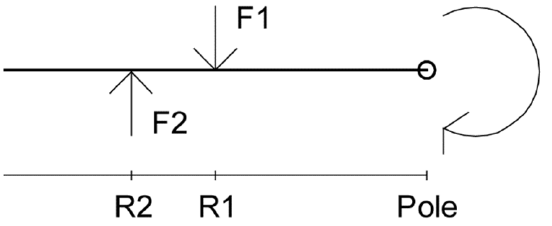
Figure A8. Representation of the masticatory system and the device with only one application point for each dental arc.